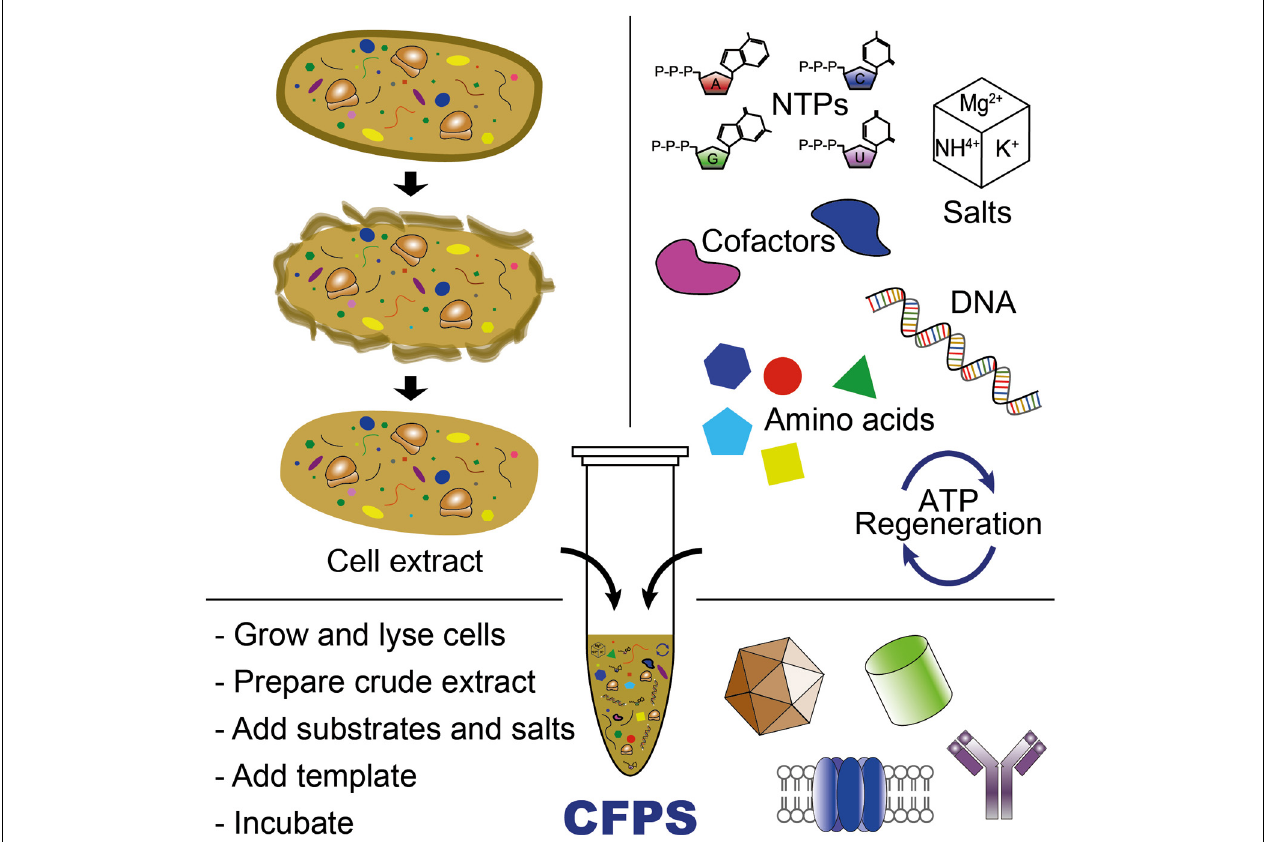
FIGURE 2 | Cell-free protein synthesis system for producing proteins or (poly)peptide-based materials. CFPS requires cell extract, an energy regeneration system, and chemical substrates and salts (e.g., NTPs, amino